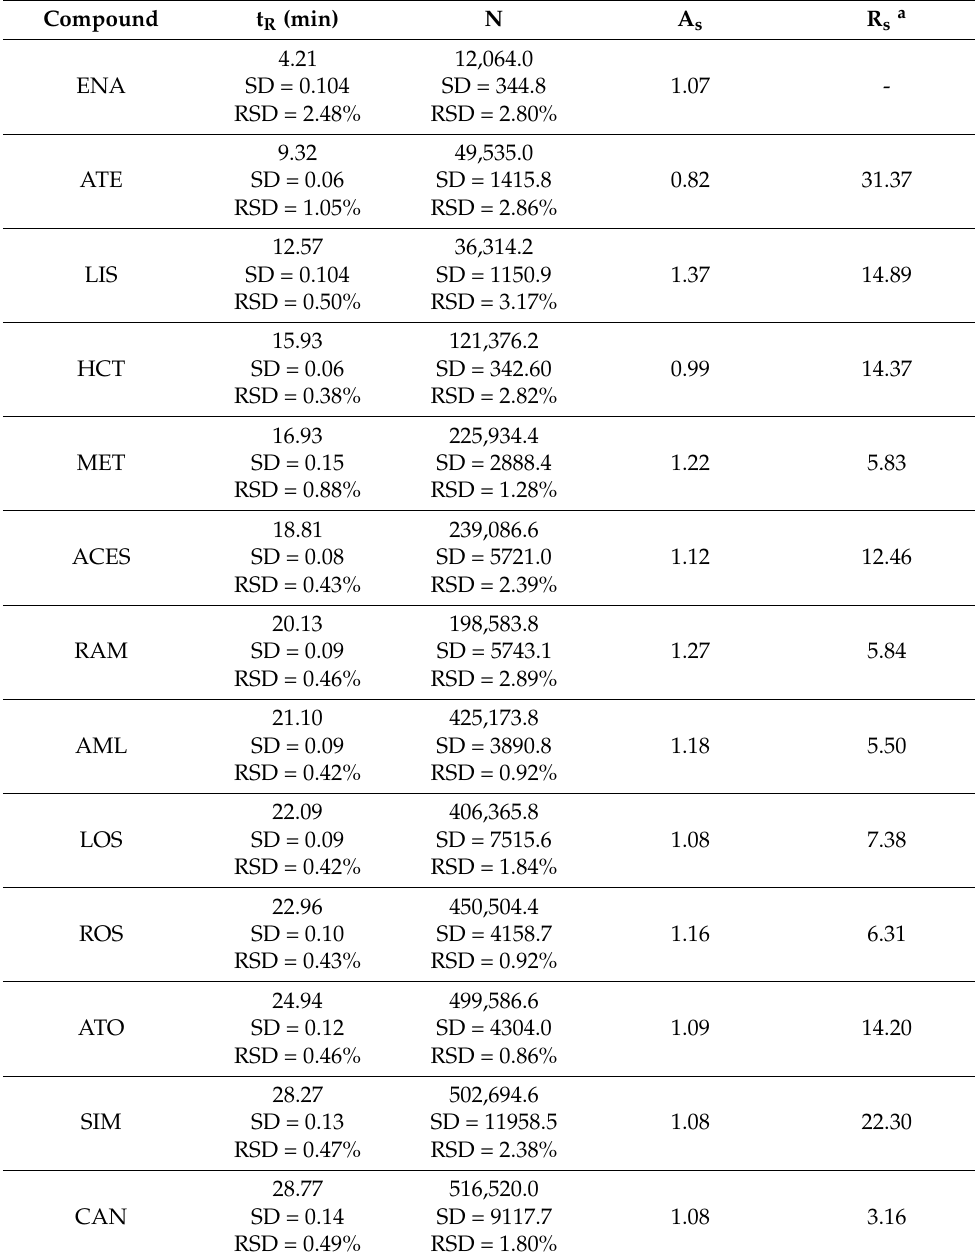
Table 3. System suitability parameters ( n =